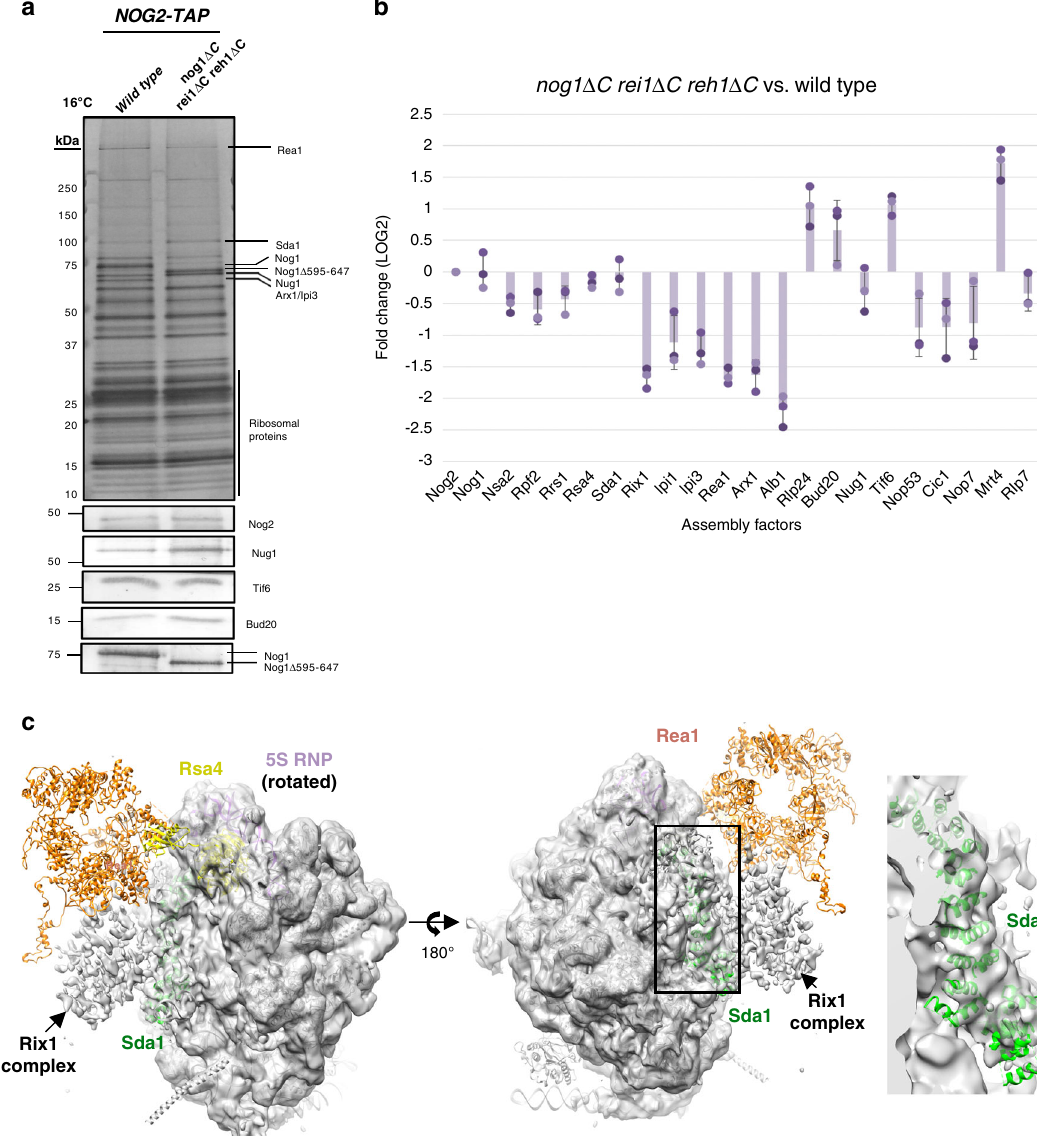
Fig. 7 Truncation of the Nog1 CTD may affect closing of the L1 stalk. a SDS-PAGE of proteins in Nog2-associated preribosomes af fi nity puri fi ed from wild-type and nog1 Δ C rei1 Δ C reh1 Δ C mutants shifted to 16 °C for 5 h. Proteins in labeled bands were identi fi ed by mass spectrometry. b Semi-quantitative iTRAQ mass spectrometry reveals differences in relative amounts of proteins labeled with iTRAQ reagents in Nog2-particles af fi nity puri fi ed from the nog1 Δ C rei1 Δ C reh1 Δ C mutant compared to those in wild-type particles. Each bar represents a biological replicate. All protein levels are normalized to the bait protein, Nog2. Ratios are represented on a log 2 scale. Error bars represent standard deviation ( n = 3). c Densities for class N4 are fi tted to the atomic model of the Rix1 particle (PDB: 5 fl 8). Density for Sda1 (green) can be seen in the particles. The 5S RNP (purple) is in the rotated state in class N4. Weak density can be seen for the Rix1 complex, and Rea1 (orange) is almost completely missing. Rsa4 (yellow) is visible in the